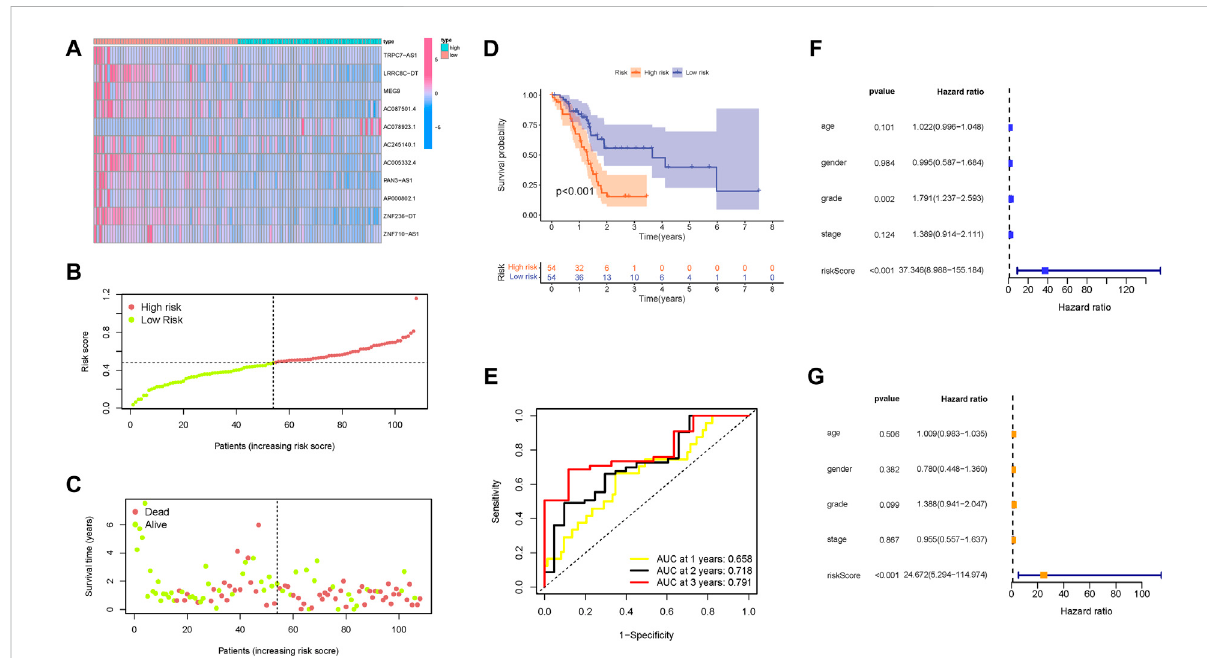
FIGURE 6 Con fi rmation of the prognostic value of the risk signature in the training group. (A) Heatmap presents the expression pattern of 11 hub m6A- related lncRNAs in each patient, where the colors yellow to blue represent alterations from high expression to low expression, respectively. (B) Distribution of the m6A-related lncRNA signature risk score. (C) Survival status and interval of PDAC patients. (D) Kaplan – Meier curve analysis presenting a difference in overall survival between the high-risk and low-risk groups. (E) Areas under curves (AUCs) of the risk scores for predicting 1-, 2-, and 3-year overall survival time. (F) Univariate Cox regression results of overall survival. The length of the horizontal line represents the 95% con fi dence interval for each group. The vertical dotted line represents the hazard ratio (HR) of all patients. (G) Multivariate Cox regression results of overall survival. The length of the horizontal line represents the 95% con fi dence interval for each group. The vertical dotted line represents the hazard ratio (HR) of all